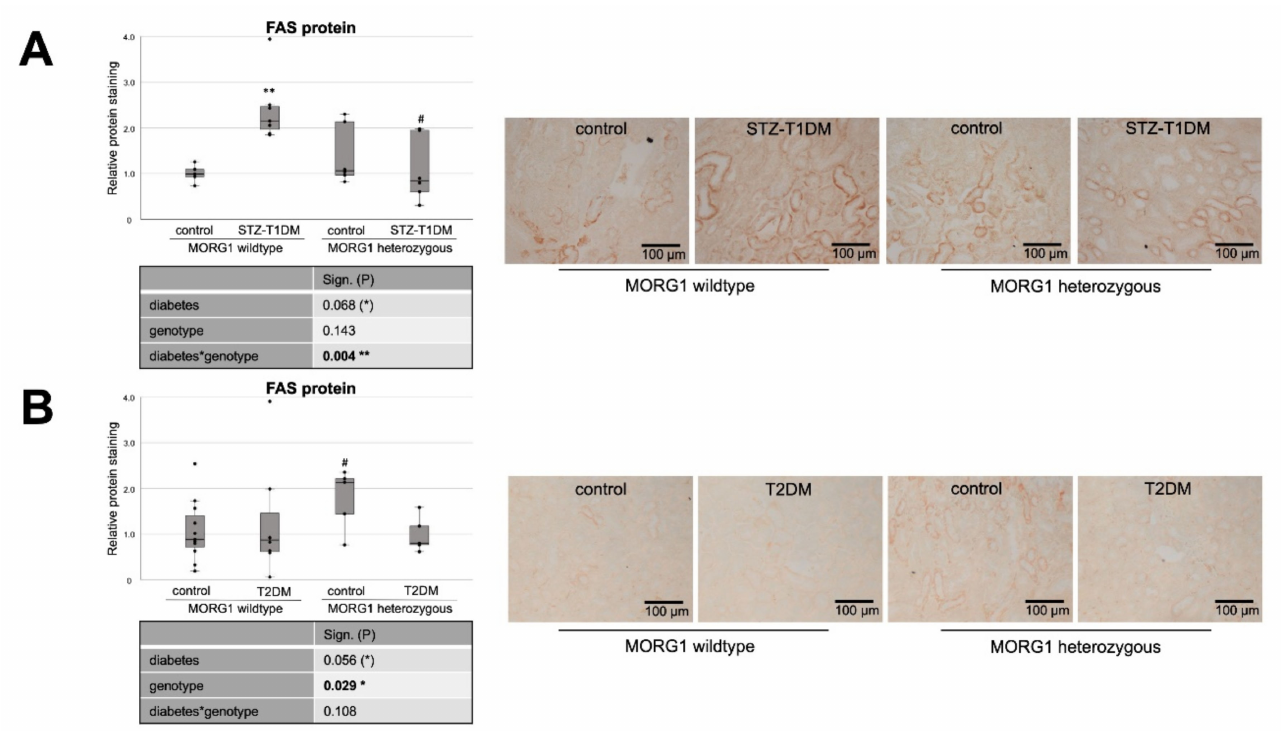
Figure 1. Role of MORG1 in de novo synthesis of fatty acids in tubular cells. ( A , B ) Immunohis- tochemistry of FAS (fatty acid synthase) in STZ-T1DM and T2DM and semi-quantitative analysis of the staining. Representative images are shown next to the graphs (magnification × 200). The significances shown in the tables were assessed by two-way ANOVA with diabetes (control or STZ-T1DM/T2DM) and genotype (MORG1 wild-type or MORG1 heterozygous) as the two factors. Diabetes, genotype: main effect of diabetes/genotype, respectively. Diabetes*genotype: interaction. Bold: statistically significant. (*) Biologically relevant. Significances shown next to each bar were assessed by using Mann–Whitney U test; ** p ≤ 0.01 in between same genotype; # p ≤ 0.05 in between different